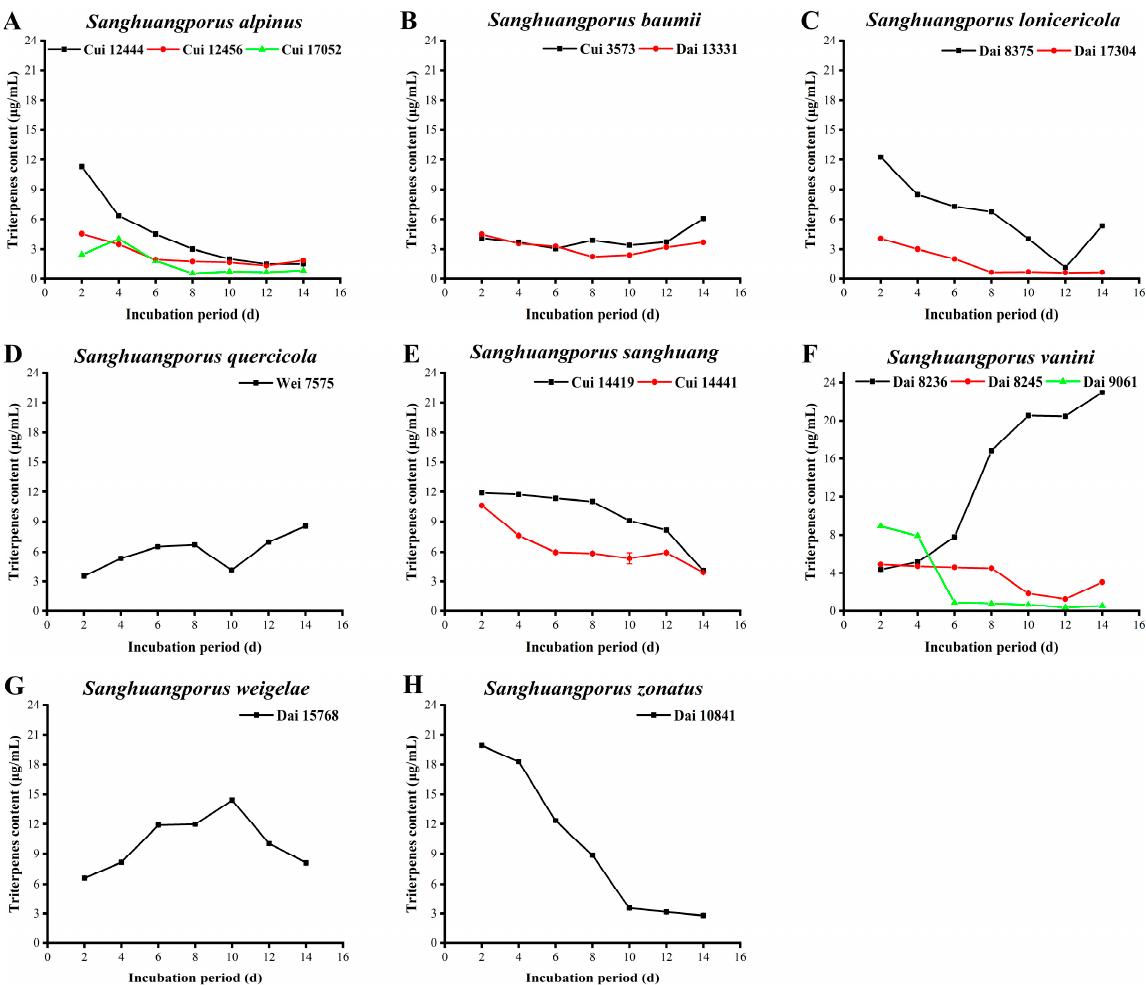
Figure 5. Variations in triterpenoid contents during submerged fermentation of 15 wild strains from